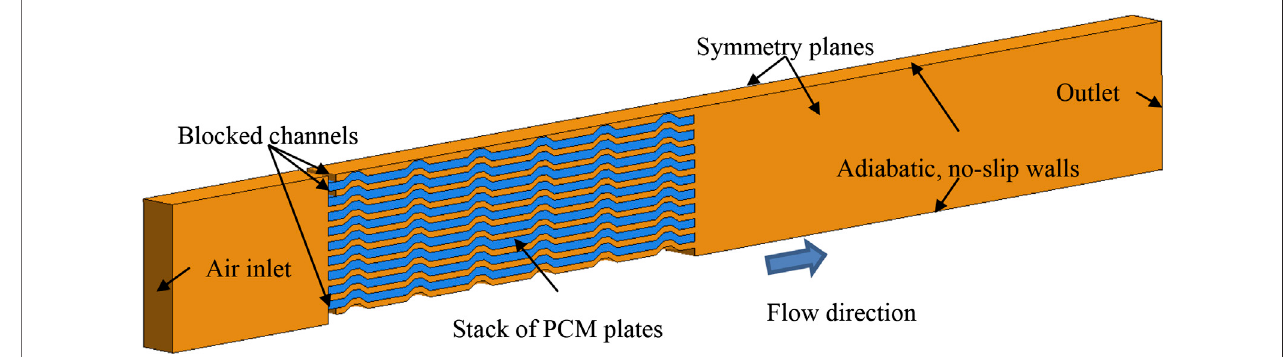
FIGURE6| Setupofthecomputational fl uiddynamics(CFD)modelofatestrigsectioncontainingtheairductandthephasechangematerial(PCM)platestack:air domain (orange) and PCM domain (blue).